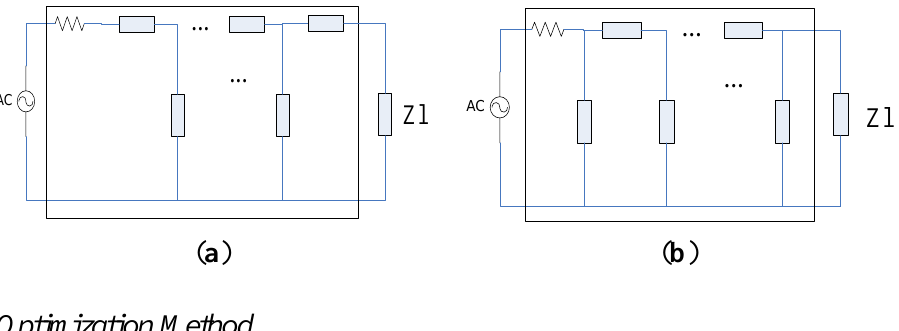
Figure 3. ( a ) T type of matching network and ( b ) π type of matching